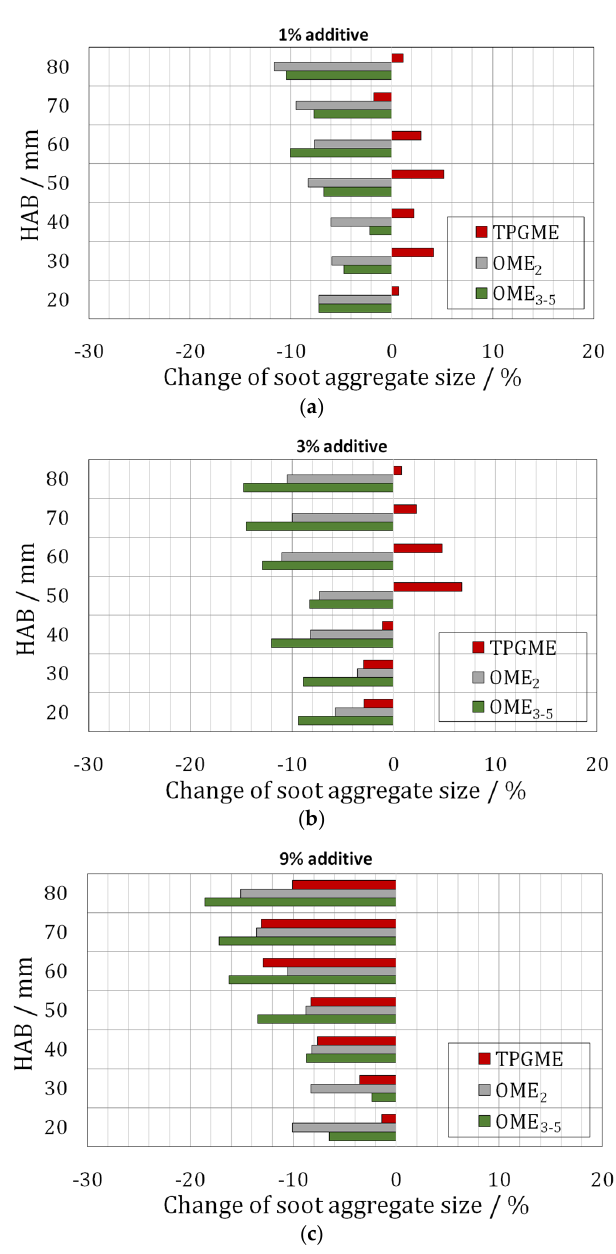
Figure 10. Comparison of µ g,eff change between TPGME, OME 2 and OME 3–5 diesel blends with respect to the baseline with ( a ) 1% of additives, ( b ) 3% of additives and ( c ) 9% of additives.